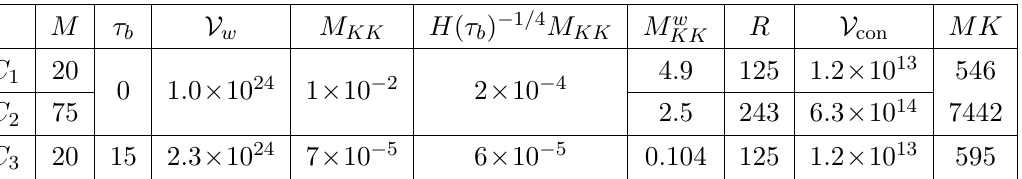
Table 2 . All points B i have τ c = 0 , T = 30 (corresponding to the unwarped conifold) and fixed H = 10 − 15 , g s = 0 . 2 . Masses are given in TeV and volumes are in string units. See main text for discussion.